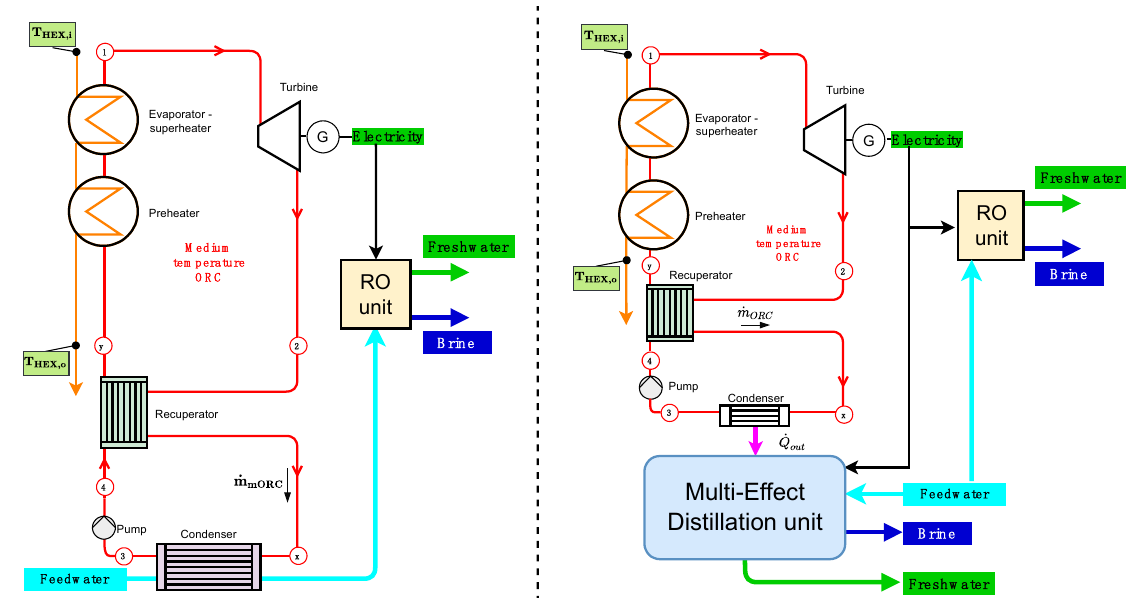
Figure 10. Configurations considered to be compared: CSP − ORC + RO ( left ) and CSP − ORC + (RO + MED) ( right ). Table 4. Comparison of the CSP − ORC configuration for desalination (same desalination